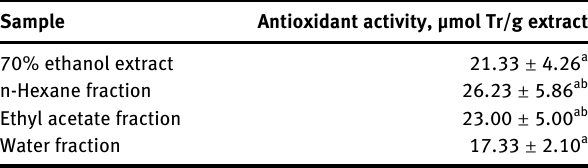
Table  : CUPRAC method antioxidant activity of extract and fraction of P. crocatum . Sample